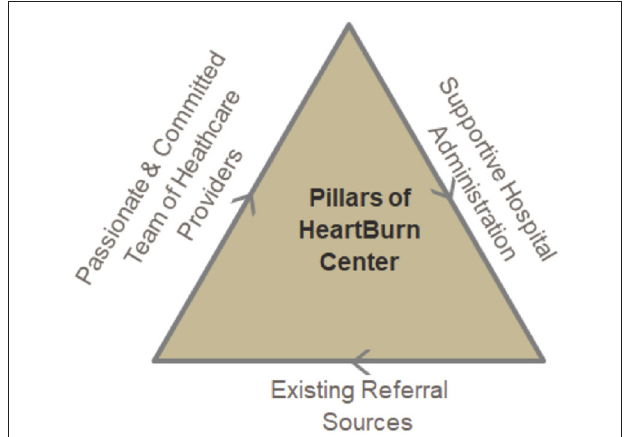
FIGURE 1 | Development of a new practice model for heartburn center of excellence.